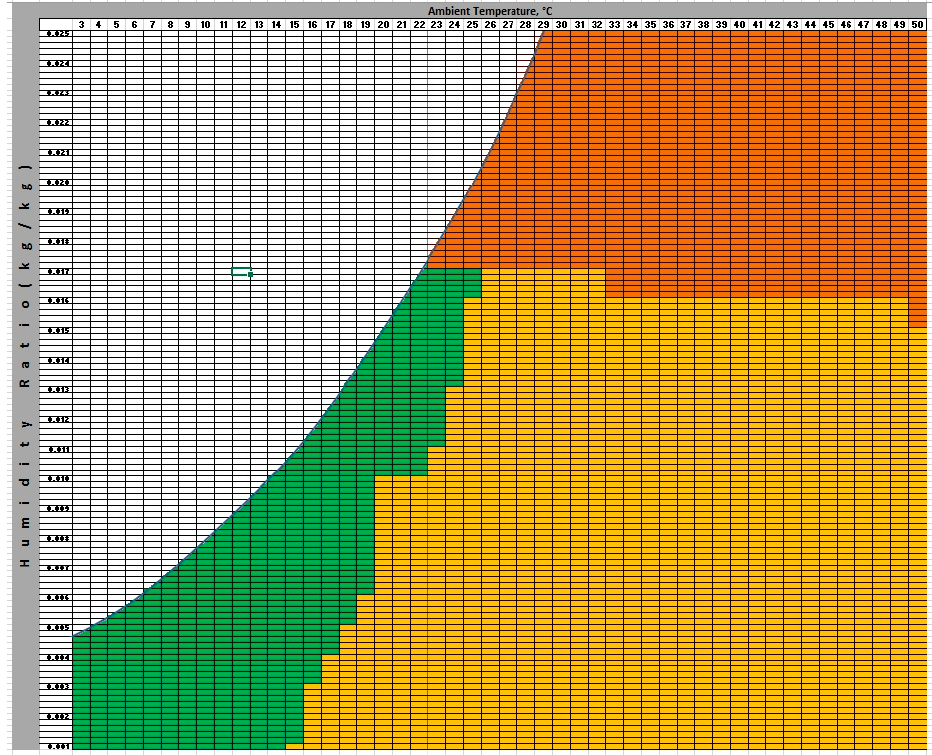
Figure 14. Operating modes of the CO 2 system enhanced with the DPC.